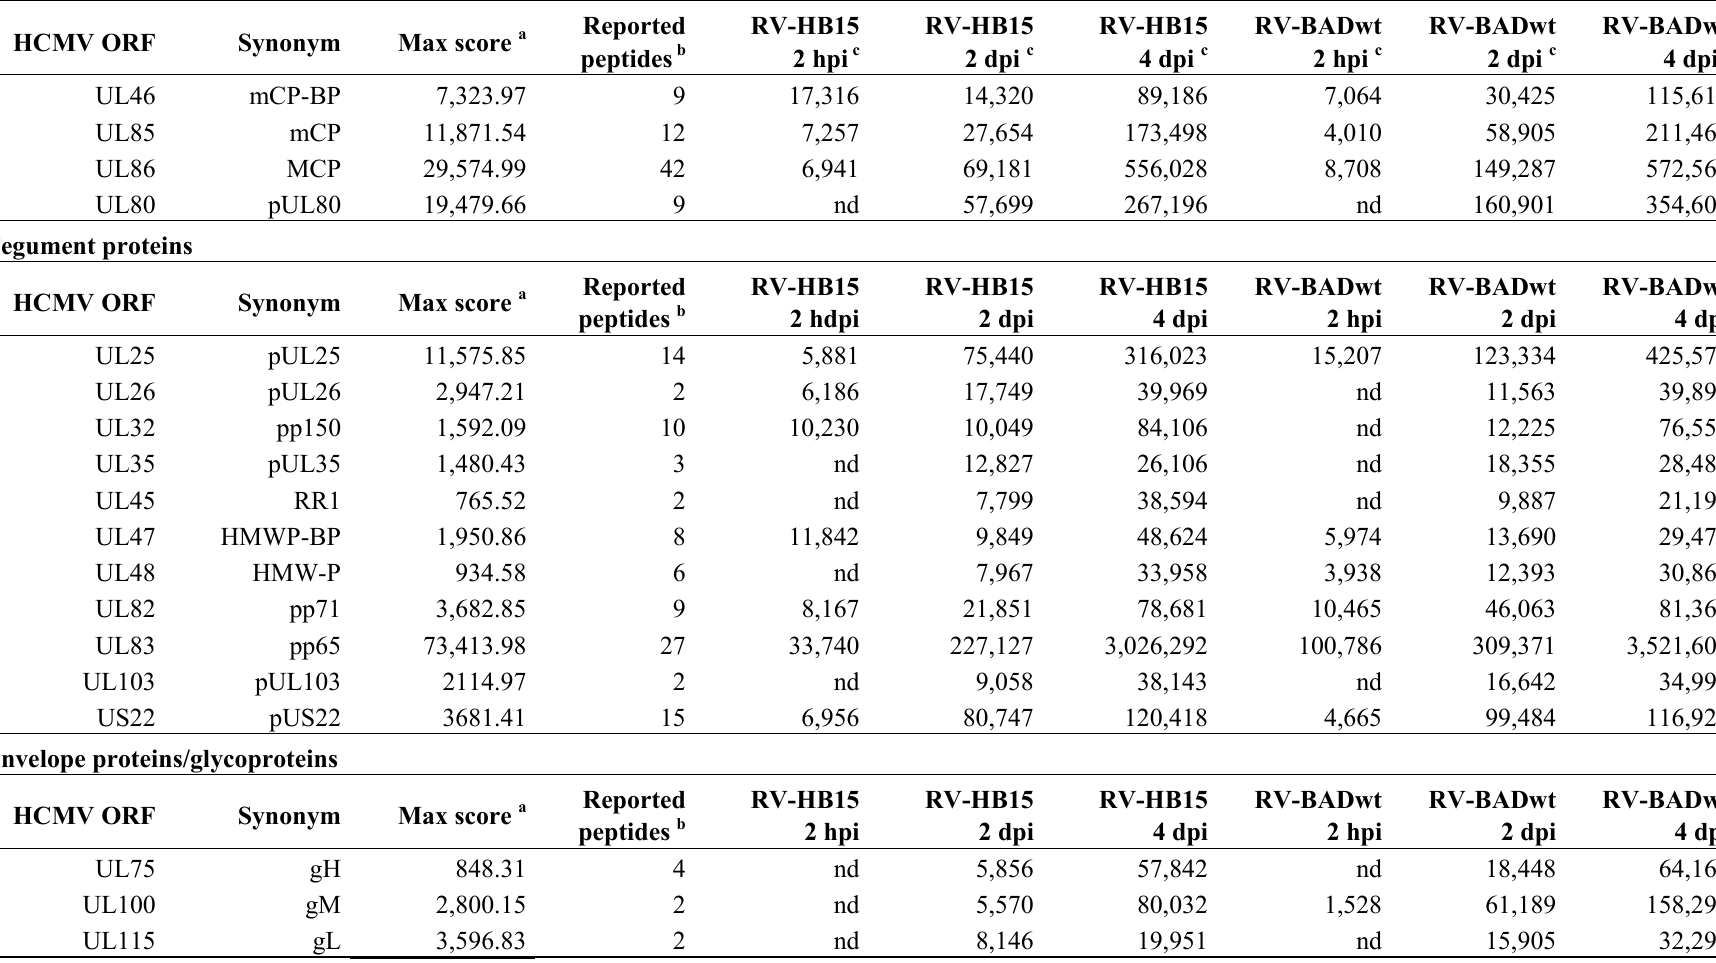
Table 1. Viral proteins detected by nanoUPLC mass spectrometry in infected